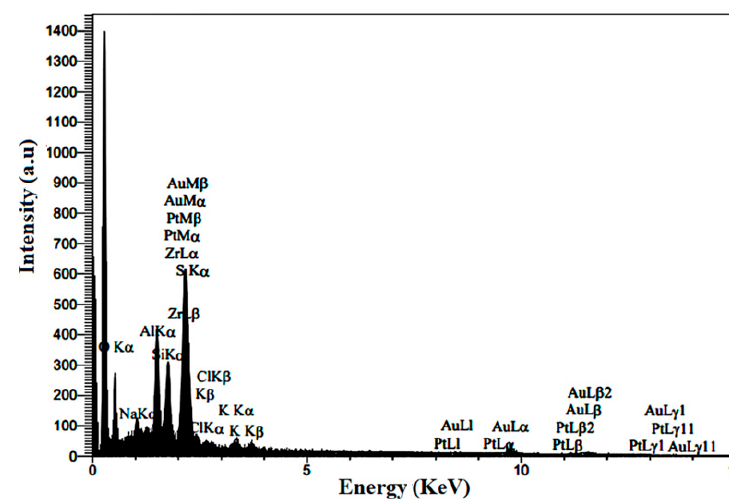
Figure 6. EDX pattern of Pt/S-ZrO 2 -GNP electrocatalyst. Table 2. Composition of Pt/S-ZrO 2 -GNP composite powder (quantitative results).